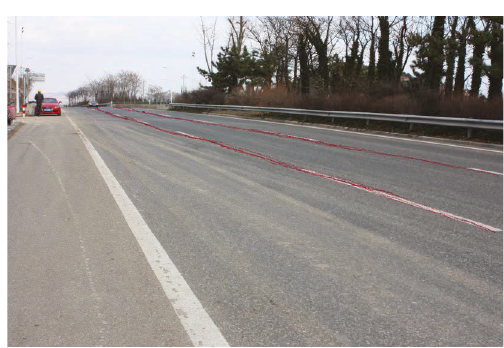
Figure 4: The detection lane areas.